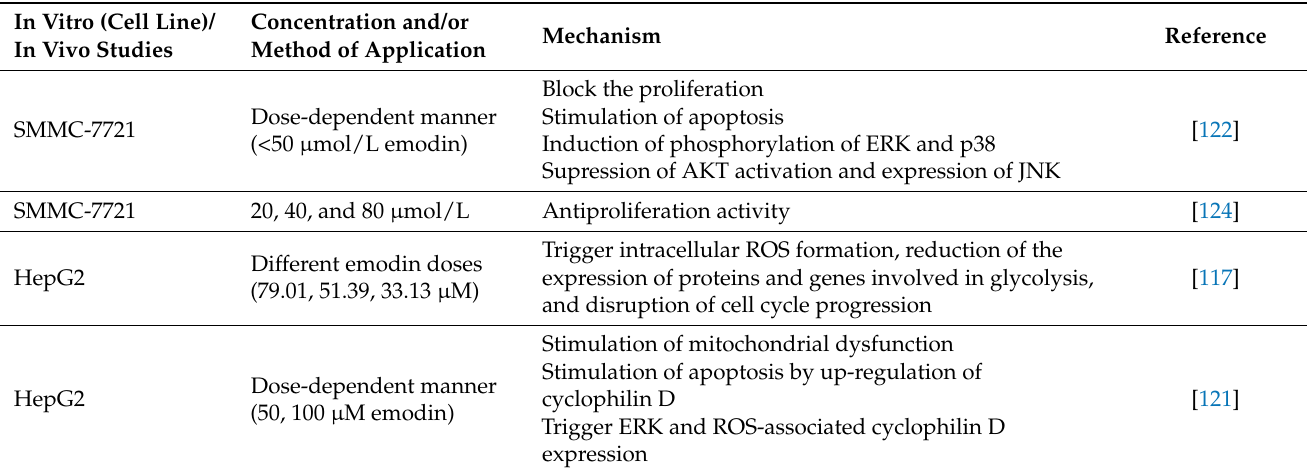
Table 5. Summary of in vitro and in vivo biochemical effects of emodin in hepatocellular cancer cell lines. In Vitro (Cell